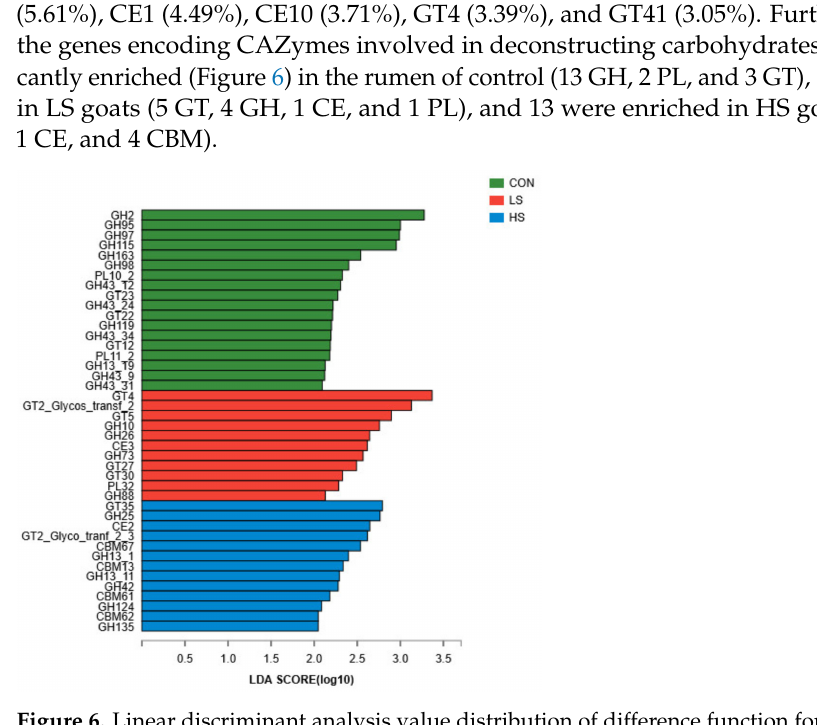
Figure 6. Linear discriminant analysis value distribution of difference function for the carbohydrate- active enzymes among the three groups. CON = basal diet; LS = basal diet + 2.4 mg/kg SY; HS = basal diet + 4.8 mg/kg